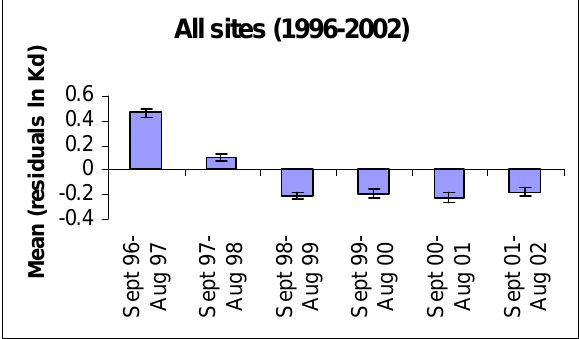
-turbidity relationship ( ln Figure 5: Residuals from the K d K = -0. 478 + 0.460 ln Turb) (data collected at d Fontainebleau, Lacombe and Pointe aux Herbes) were plotted against the survey